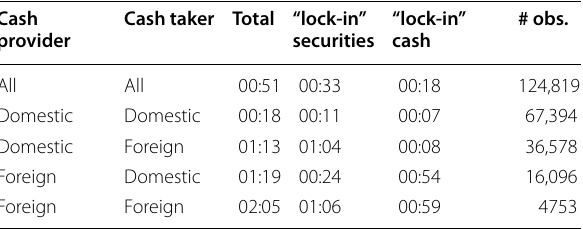
Table 1 Average time to settlement for interbank transactions